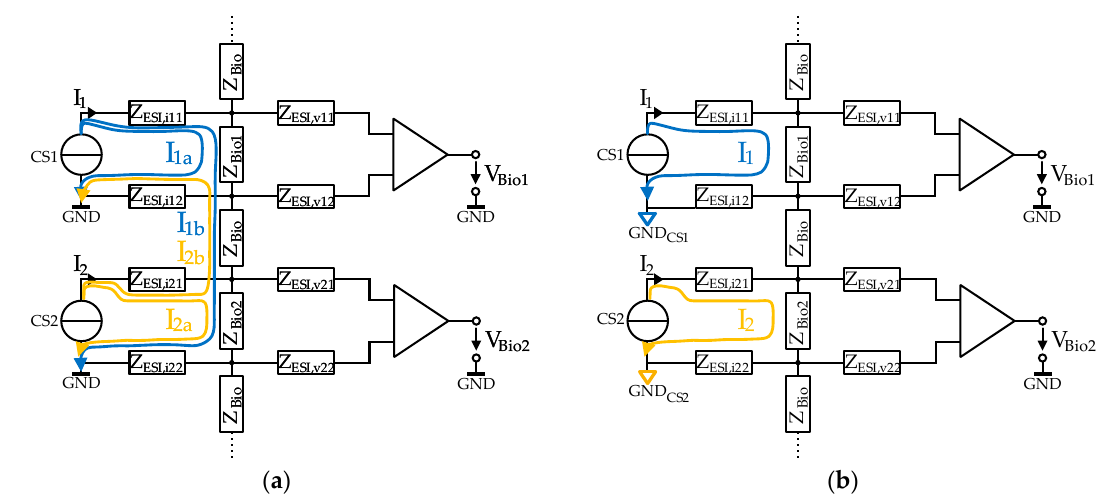
Figure 1. Simplified equivalent circuit of a simultaneous 2-channel bioimpedance measurement without ( a ) and with ( b ) galvanic decoupling of the current sources.